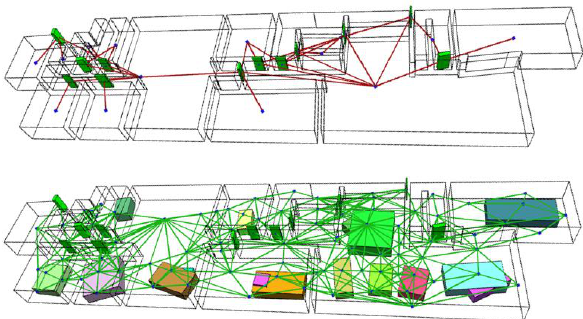
Figure 7: Top: extraction of a basic navigation graph using spaces and door (green). Bottom: Advanced navigation graph accounting for obstacles and 3D accessibility. This graph can be utilized for navigation